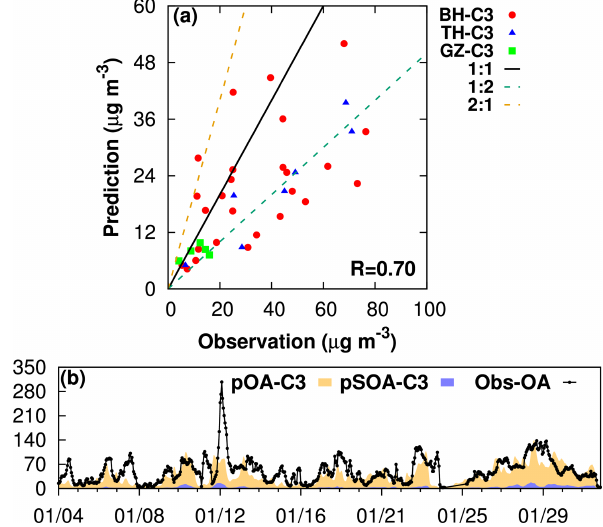
Figure 1. Comparison of (a) observed and modeled organic carbon concentration at the University of Beihang (BH), Tsinghua Univer- sity (TH), and Guangzhou (GZ); (b) observed organic aerosol (Obs- OA) at Beijing and predictions of total OA (pOA) and SOA (pSOA; µgm − 3 ). The locations of the monitoring sites are shown in Fig.